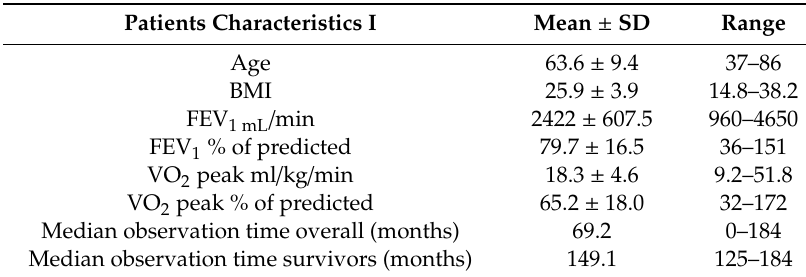
Table 1. Characteristics of 342 patients undergoing curative resection for non-small cell lung